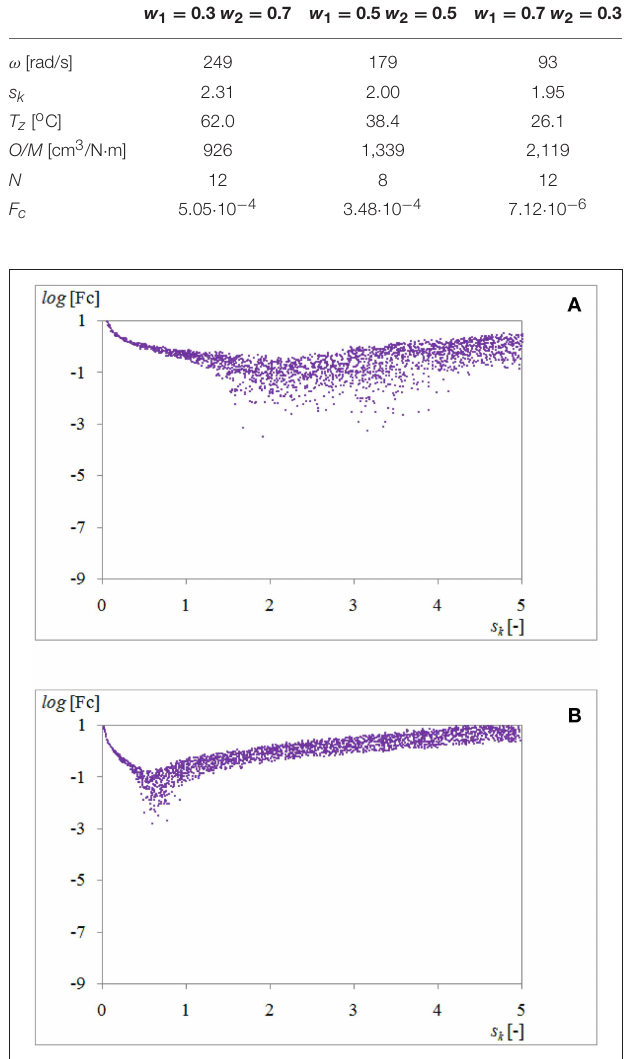
FIGURE 3 | A set of values of the objective function described by the formula (8) for U = 2 kV, 30 ≤ ω ≤ 250 rad/s, 5 ≤ n ≤ 13, w = 30% and for: (A) w 1 = 0.3, w 2 = 0.7; (B) w 1 = 0.7, w 2 = 0.3.